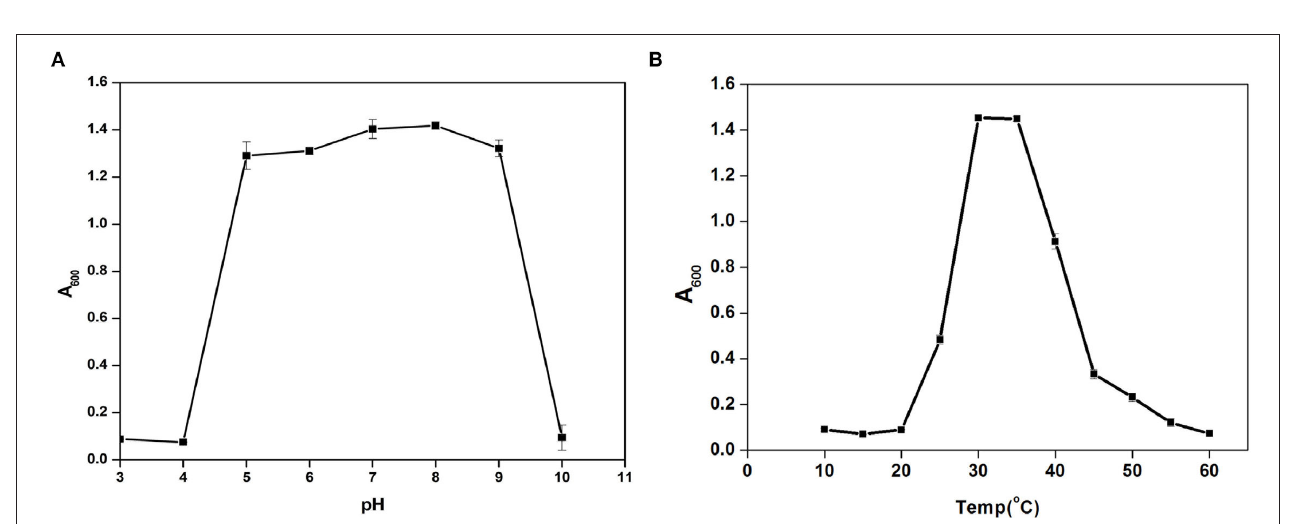
FIGURE 5 | Growth pattern assessment of the Cytobacillus oceanisediminis NB2in Luria-Bertani broth with diverse pH (3–10 with an interval of 1.0 pH) (A) and temperature (10–60 ◦ C with an interval of 5 ◦ ) (B) conditions for 24h with constant shaking at 200 rpm. Each point in the graph is the mean value of readings observed in triplicate